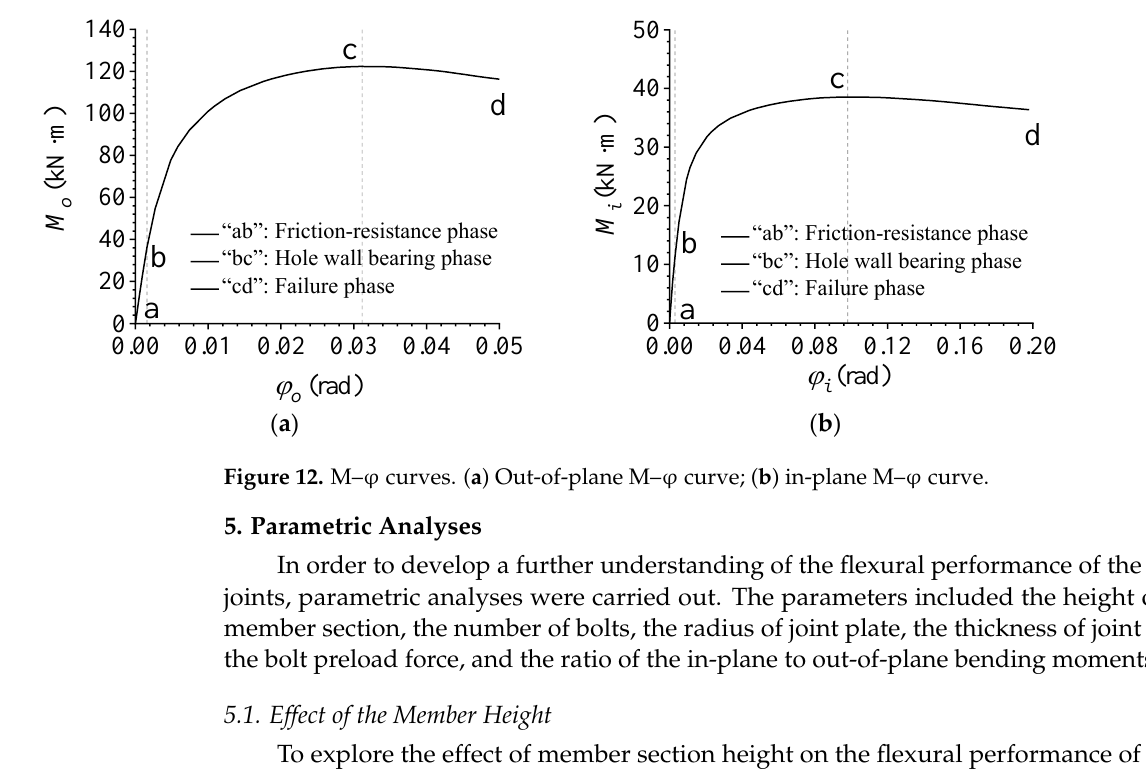
Figure 11. Deformation process of AAG joints. ( a ) Initial phase; ( b ) friction-resistance phase; ( c ) hole wall bearing phase; ( d ) failure phase.